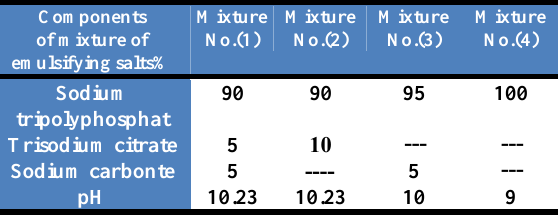
Table, 1: The percentage of the four components of mixtures of emulsifying salts used in the experiment and the results of the change in